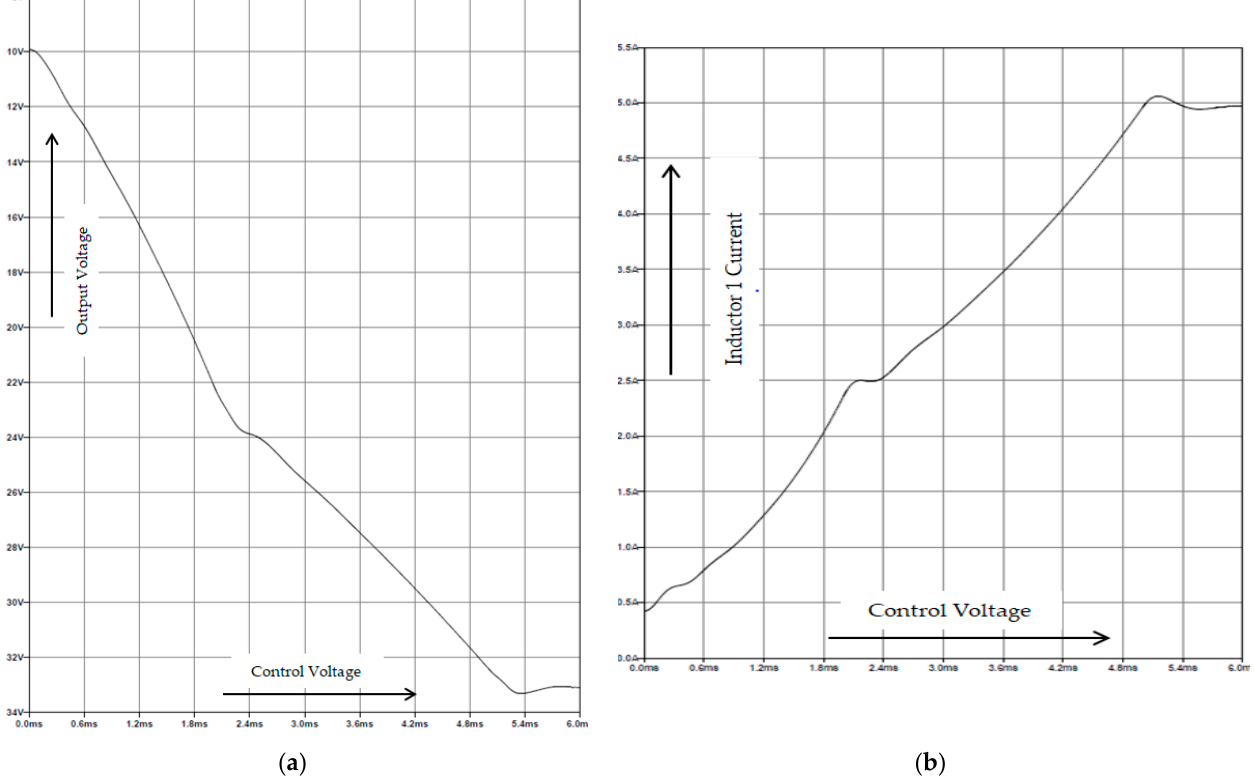
Figure 10. Variation of iL1 and V 0 with change in D (Cuk). ( a ) Output Voltage Vs. Control Voltage, ( b ) Inductor 1 Current Vs. Control Voltage